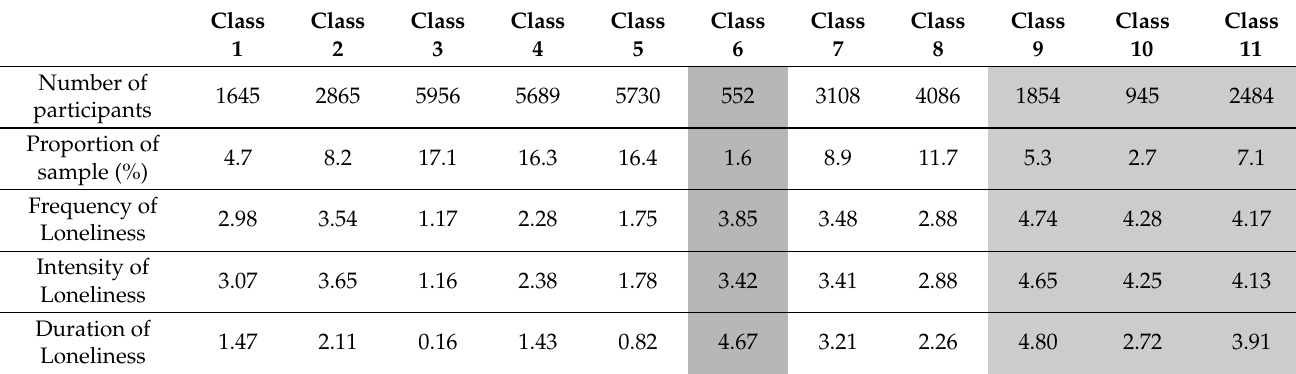
Table 5. Means on different aspects of severity of loneliness for each class identified in the final